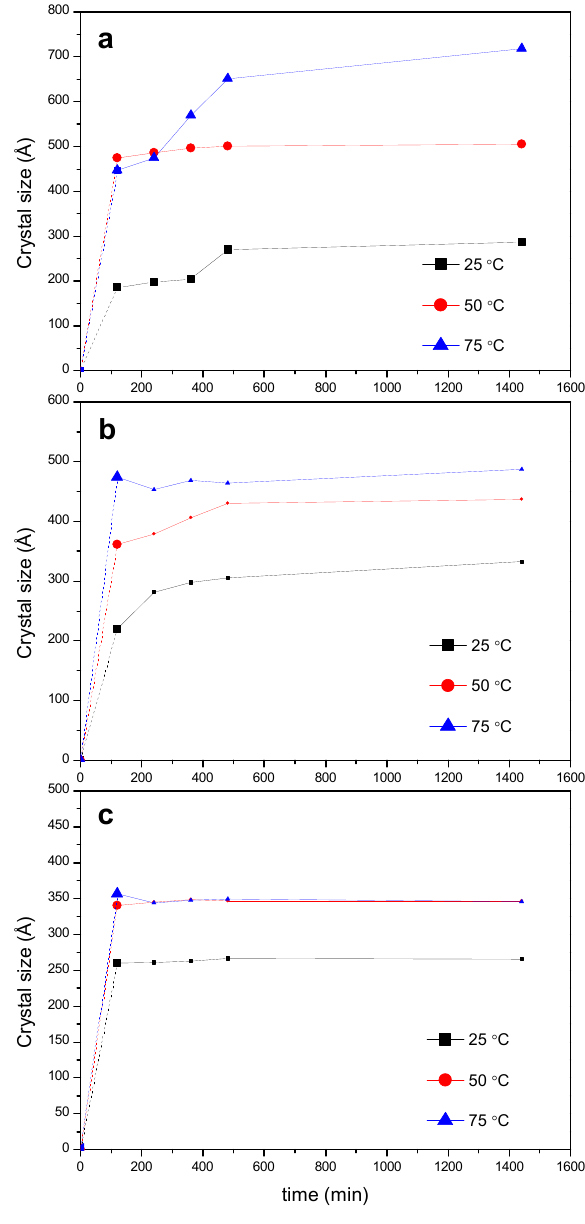
Figure 7. Evolution of the crystal size of the PPR c at different temperatures (calculated from the 2 θ = 19.9° peak) for different reaction feeds PEG400: α -CD: ( a ) 1:0.5; ( b ) 1:1; ( c ) 1:2.